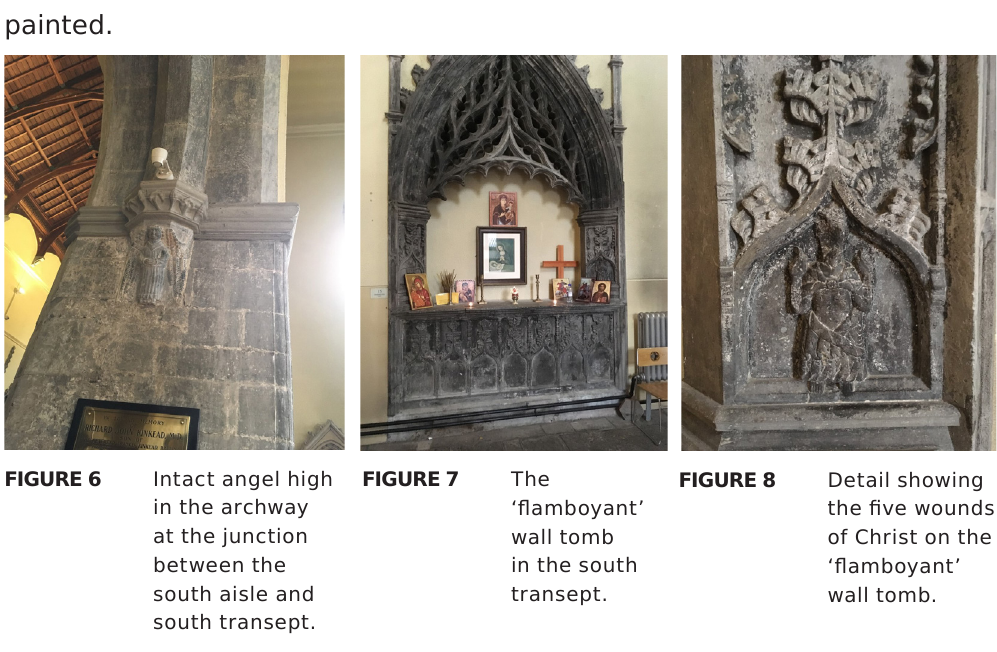
Intact angel high in the archway at the junction between the south aisle and south transept.